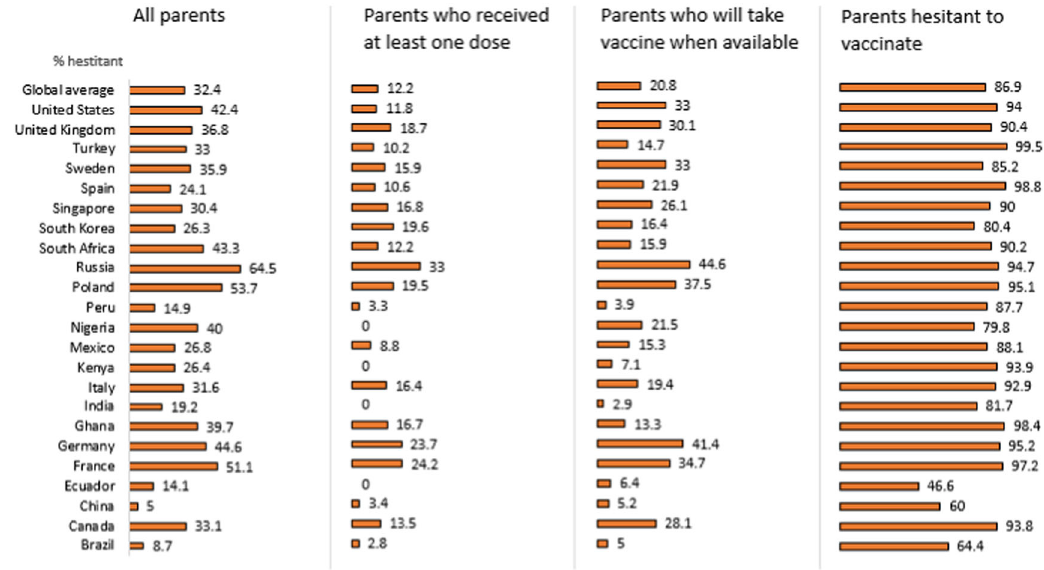
Fig. 3 COVID-19 vaccine hesitancy for children among parents. Vaccine hesitancy was de fi ned as having reported “ no ” to the question on whether respondents received at least one dose of a COVID-19 vaccine and also either “ unsure/no opinion, ” “ somewhat disagree, ” or “ strongly disagree ” to the question on whether they will take COVID-19 vaccine when available to